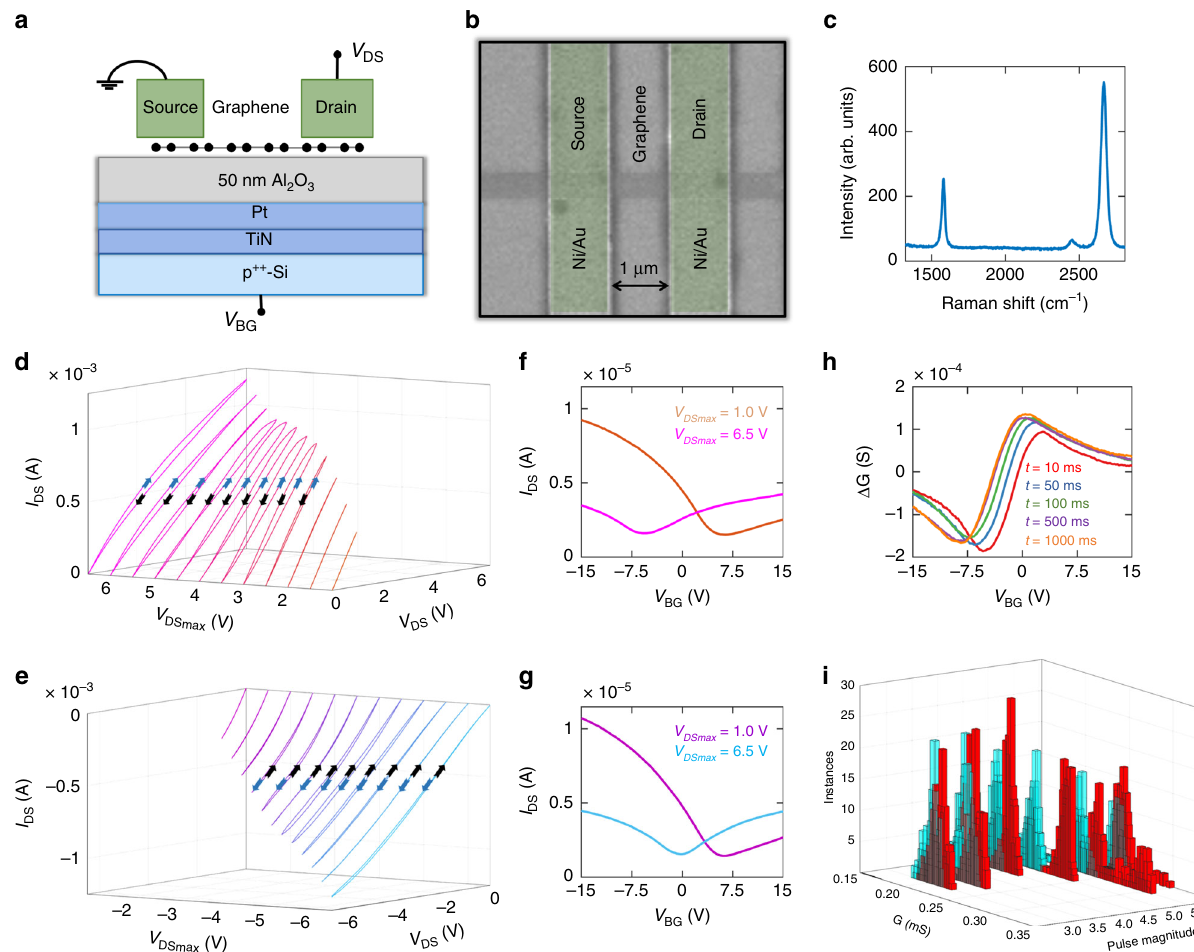
Fig. 1 SET process for graphene memristors. a Schematic and ( b ) false-colored scanning electron microscope (SEM) image of a graphene memristor. c Raman spectrum of the graphene channel, taken at a wavelength of 532 nm. Output characteristics (i.e., the source-to-drain current ( I DS ) versus the drain-to-source voltage ( V DS )) of an as-fabricated graphene fi eld effect transistor (GFET) at V BG = 0 V for different V DS sweep ranges (denoted by V DSmax ), from ( d ) 1 V to 6.5 V and ( e ) − 1 V to − 6.5 V in steps of 0.5 V. The arrows denote the sweep direction (blue for the forward sweep and black for the reverse sweep). In either case, the hysteresis window initially increases with increasing V DSmax before reversing direction and starting to decrease past V DSmax = 5 V for ( d ) and V DSmax = − 5.5 V for ( e ). These results indicate switching between states of lower and higher conductance in GFETs. Transfer characteristics at V DS = 10 mV following the sweeps of ( f ) V DSmax = 1 V and V DSmax = 6.5 V and ( g ) V DSmax = − 1 V and V DSmax = − 6.5 V. Sweeping the GFET to a higher positive V DSmax results in a large shift of the Dirac voltage from V Dirac = 6.4 V to V Dirac = − 5.8 V, making the GFET more n-type, whereas sweeping the GFET to a higher negative V DSmax results in a smaller shift from V Dirac = 6.5 V to V Dirac = − 0.2 V, making the GFET more ambipolar. h Difference between the conductance of two states as a function of V BG after the sequential application of positive and negative V DS pulses of magnitude 5 V for different pulse durations ( t ) at V DS = 10 mV. i Switching endurance. Histogram of conductance distributions following 200 cycles of SET (red) and RESET (blue) pulses of different magnitudes. Conductance states obtained using V DS pulses of magnitude 5 V display both a relatively large difference in conductance and a switching endurance >200 cycles. These experiments demonstrate the ability to SET and RESET conductance states in graphene by applying V DS pulses of opposite polarity, making it attractive for non-volatile memory (NVM)